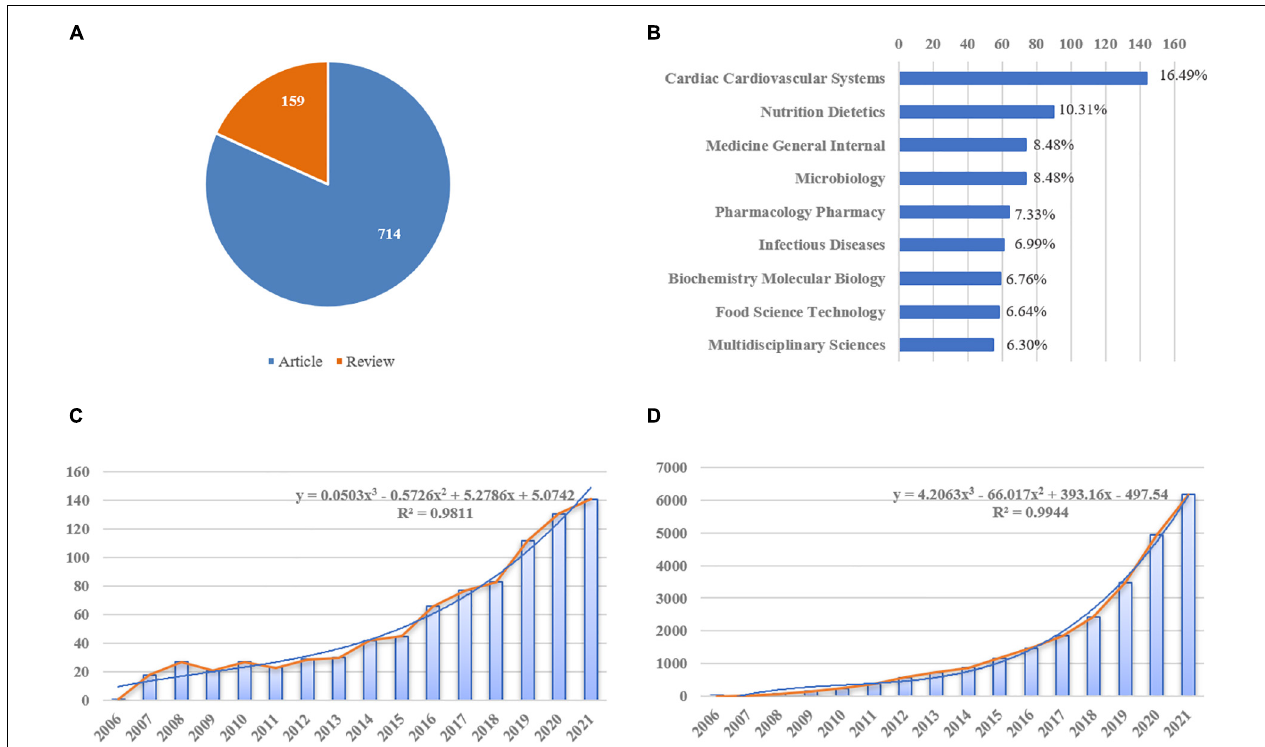
FIGURE 3 | Yearly quantity and literature type of publications on gut microbiota and heart failure from 2006 to 2021. (A) Literature types distribution, the blue represents articles and orange represents reviews. (B) Subject categories distribution. (C) Annual publications quantitative distribution. (D) Annual cite distribution, the blue line represents the polynomial-fitted growth